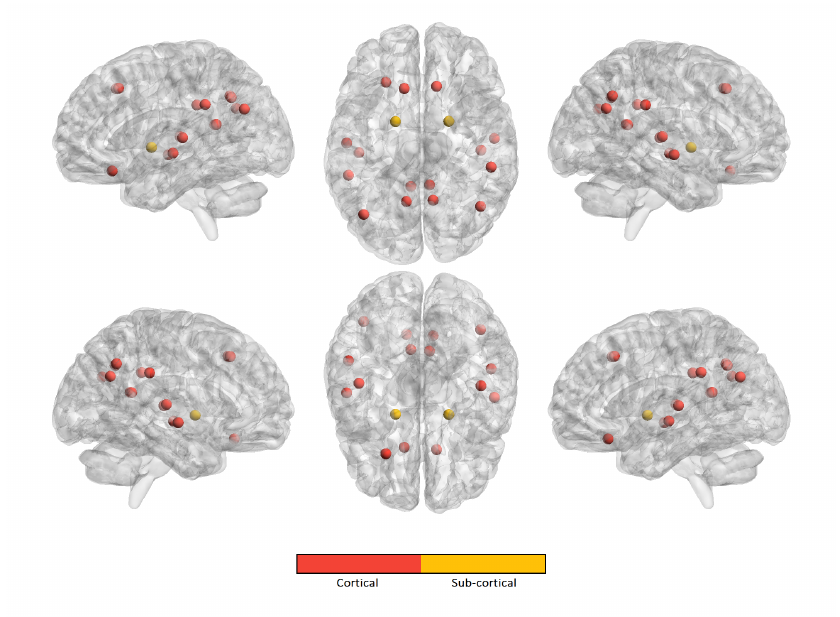
Figure 8. The most significant ROIs for the RF age prediction with age covariate harmonization in ASD